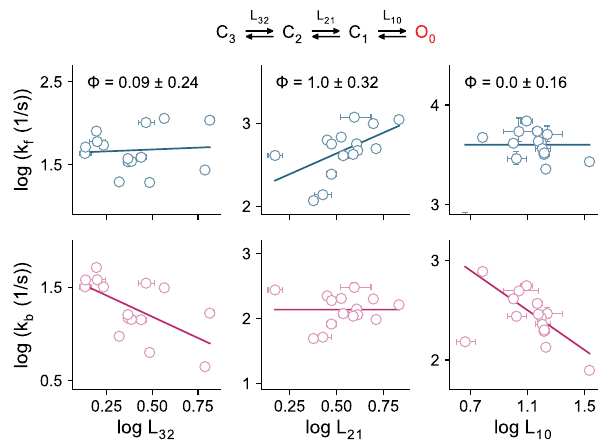
Fig. 6 Rate-equilibrium free-energy relations of the gating steps. Plots show the experimental relation between the forward (blue) and backward (red) rate constants and the corresponding equilibrium constants for the transitions relating the gating intermediates and end points (from C 3 to O 0 ). Each data point corresponds to the parameter(s) obtained for a mutant in the gate region shown in Supplementary Fig. 7d. Errors correspond to 95% con fi dence intervals (respective error bars are not visible when they are smaller than the symbols). Solid lines are fi ts to the pair of rate-equilibrium free energy relations for each transition (Eq. 36). The estimated value of phi is presented as best- fi t ± standard